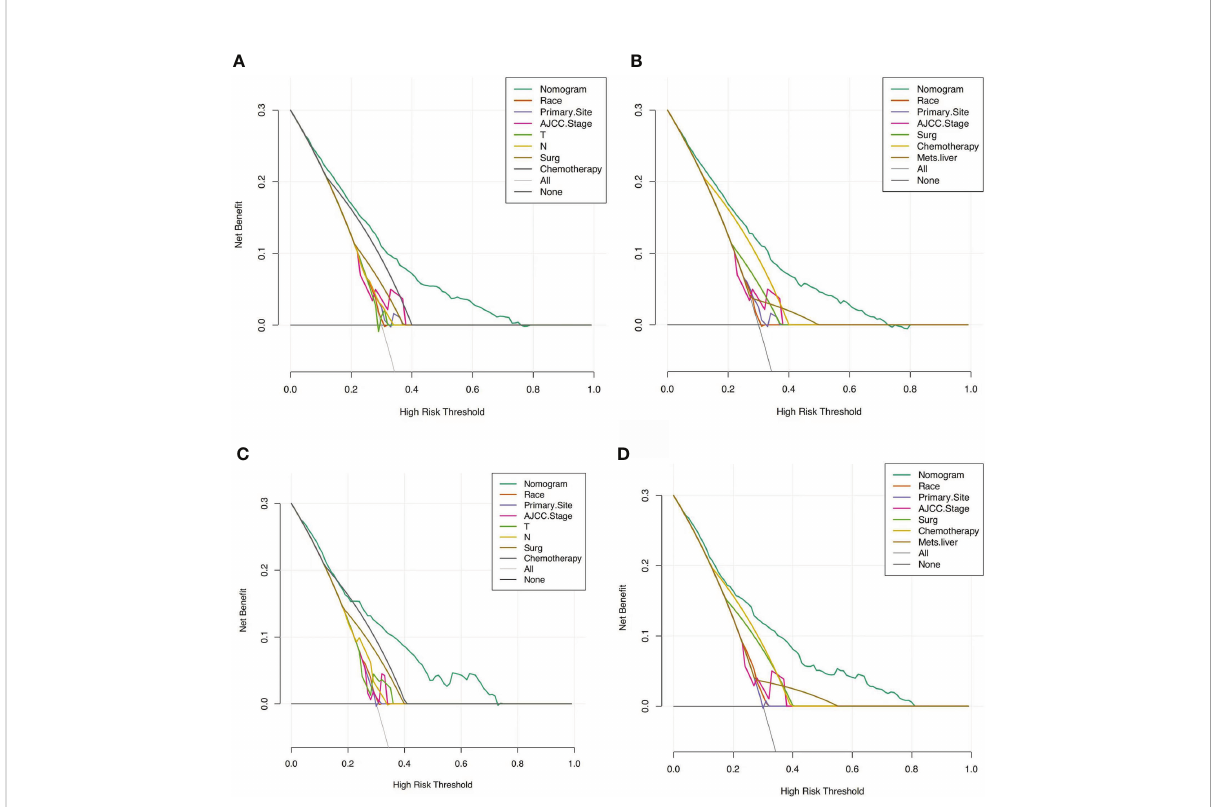
FIGURE 6 DCAs for the nomograms in predicting all-cause and cancer-speci fi c early death in the training cohort (A, B) and the validation cohort (C, D)